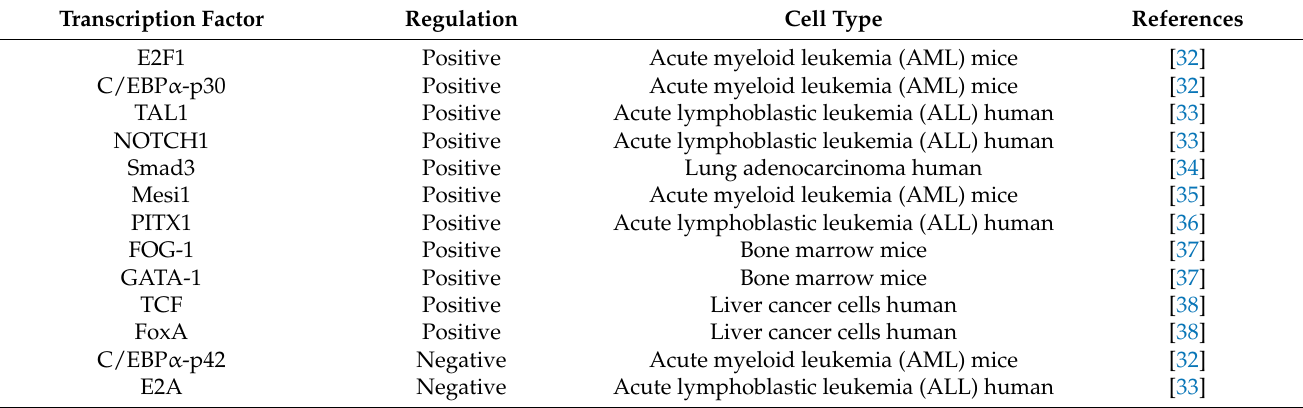
Table 1. Summary of transcription factors demonstrated to regulate